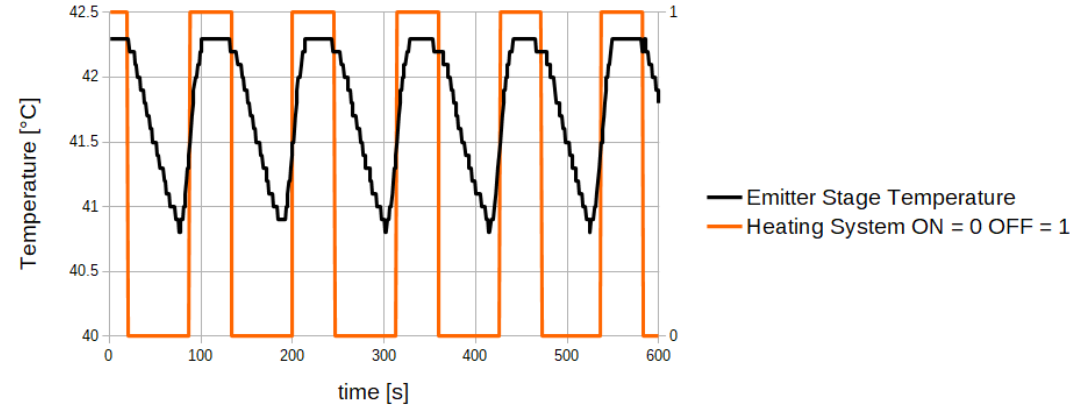
Figure 14. Emitter Stage Temperature trend obtained through the temperature control